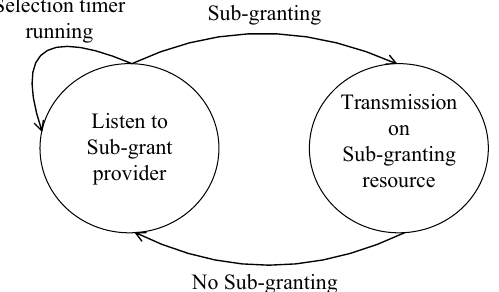
Fig. 2 State‑machine diagram of a beneficiary user functionality on the dedicated sub‑granting